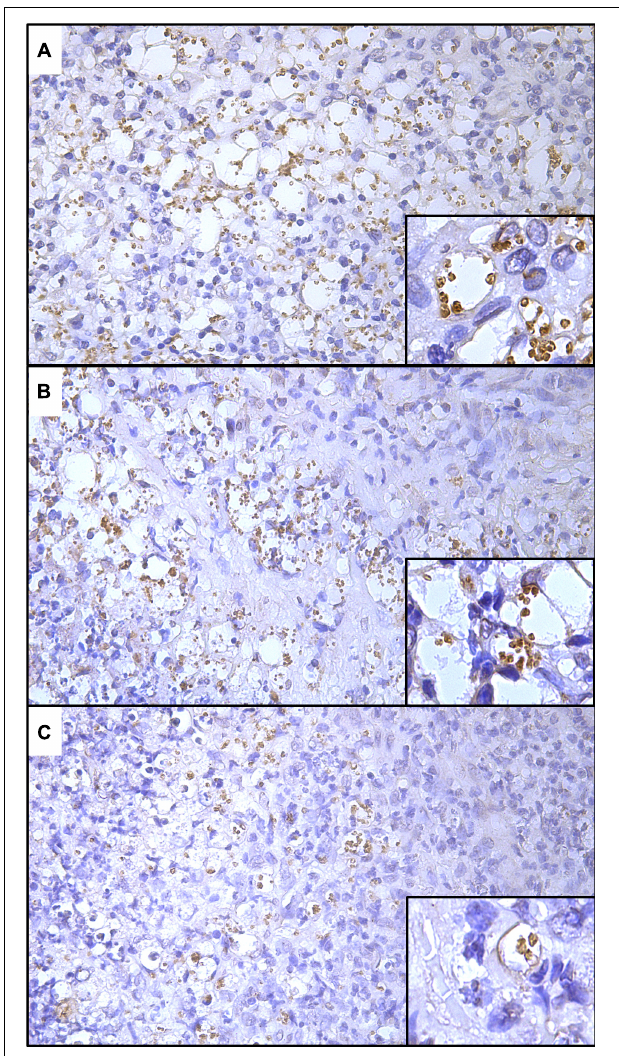
FIGURE 2 | Histological sections of skin lesions from golden hamsters experimentally infected with L. amazonensis (A) , L. braziliensis (B) , and L. guyanensis (C) showing the labeling of amastigote forms by IHC-HRP using anti-mTXNPx mAb (IHC-HRP, 280 × ). Detail showing amastigote within parasitophorous vacuoles (700 × ).